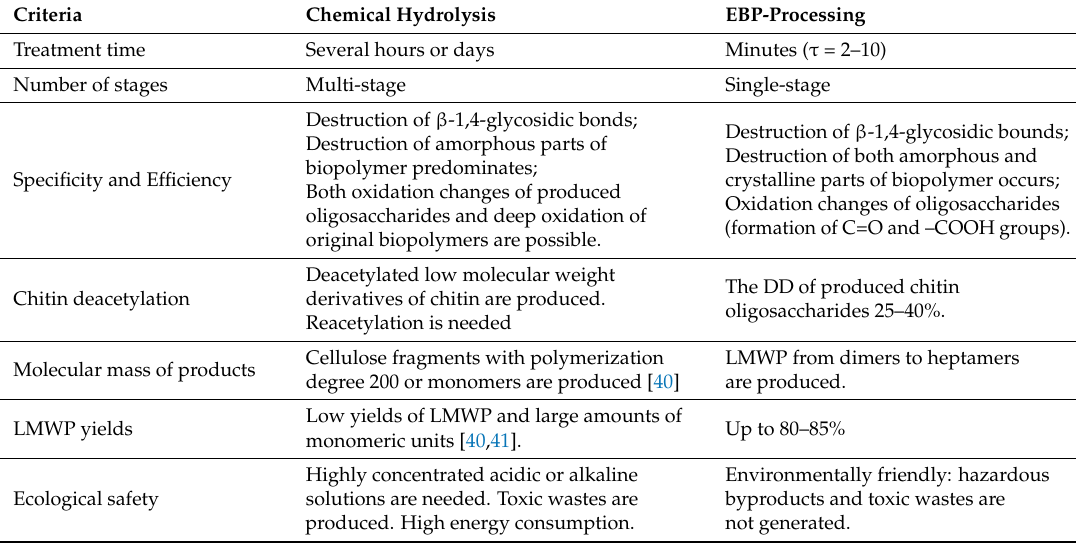
Table 2. The comparison of the EBP-stimulated polysaccharides destruction with respect to acid-catalyzed chemical